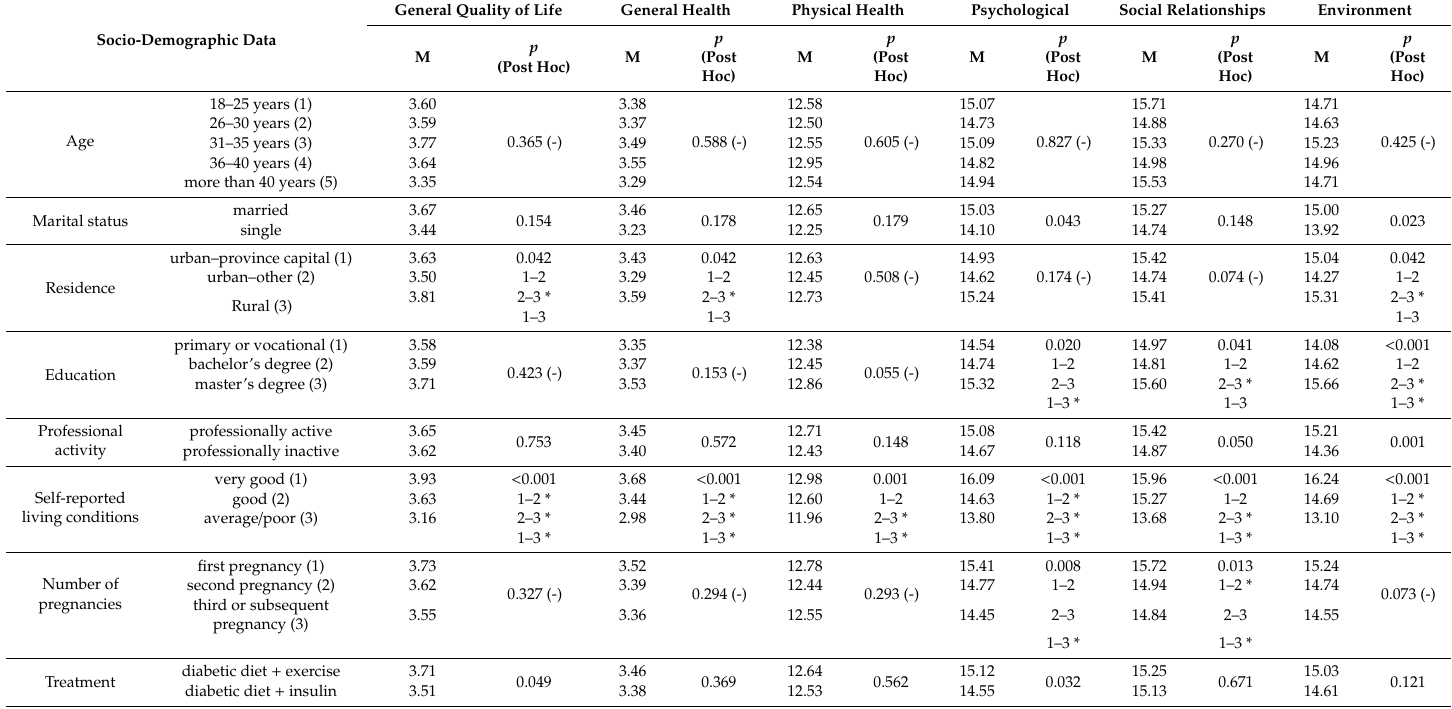
Table 4. Analysis of correlations between quality of life (WHOQOL-BREF) and socio-demographic variables among pregnant women with hyperglycemia. General Quality of Life General Health Physical Health Psychological Social Relationships Environment Socio-Demographic Data M